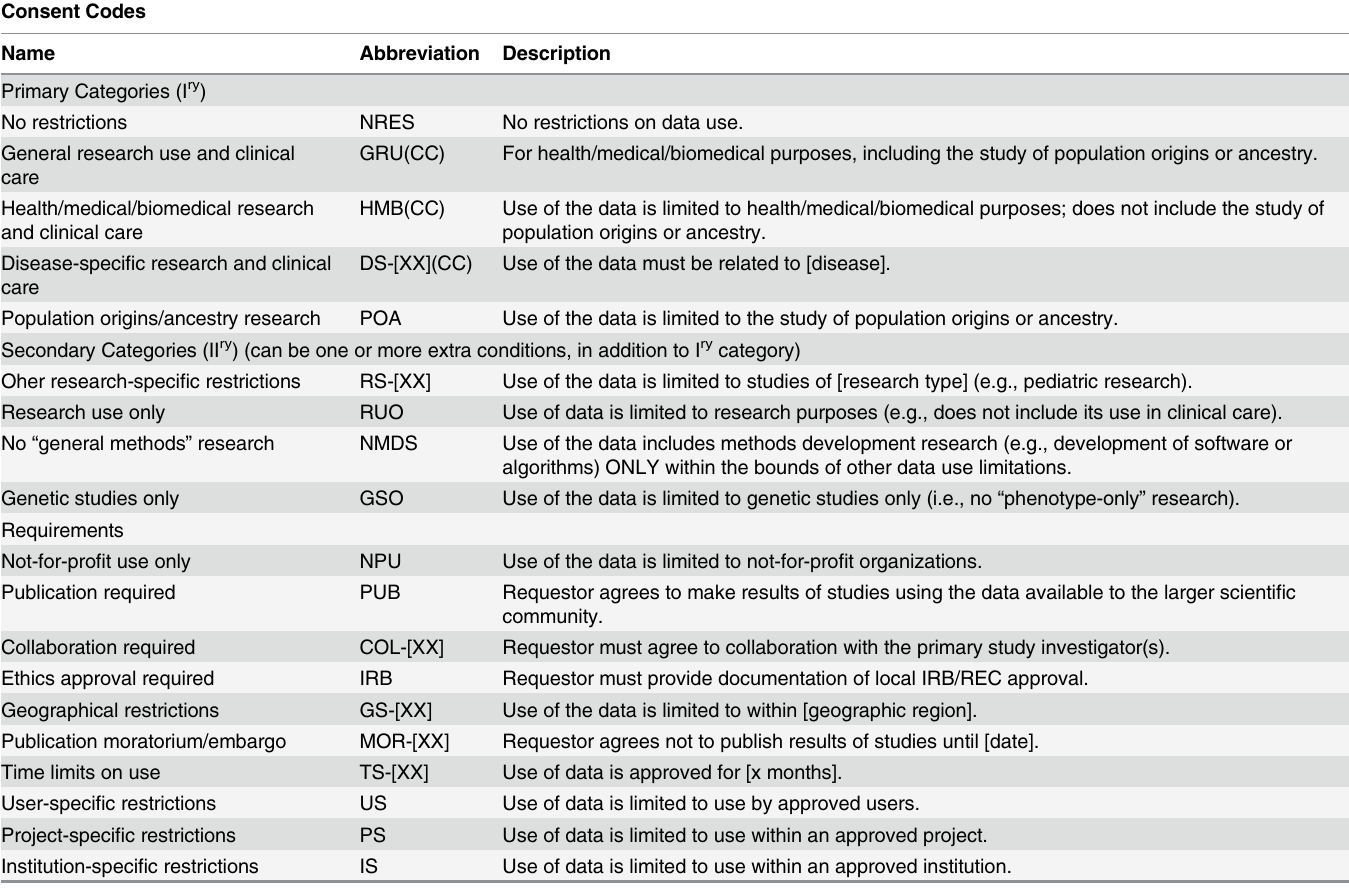
Table 1. Data use categories and requirements (Consent Codes): definition and